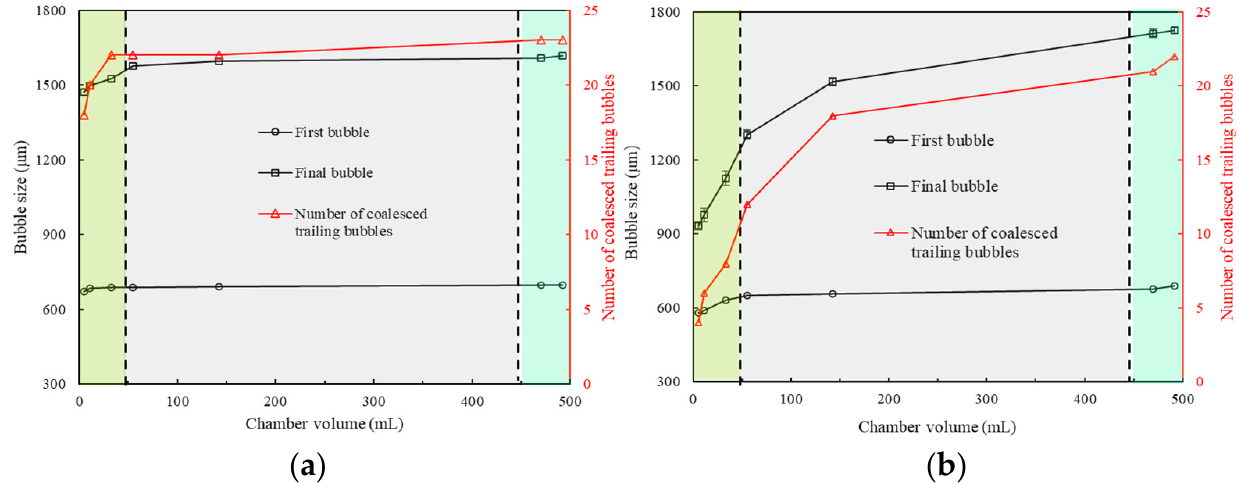
Figure 5. Effects of chamber volume on bubble formation under steady air pattern ( a ) and oscillatory air pattern ( b ).